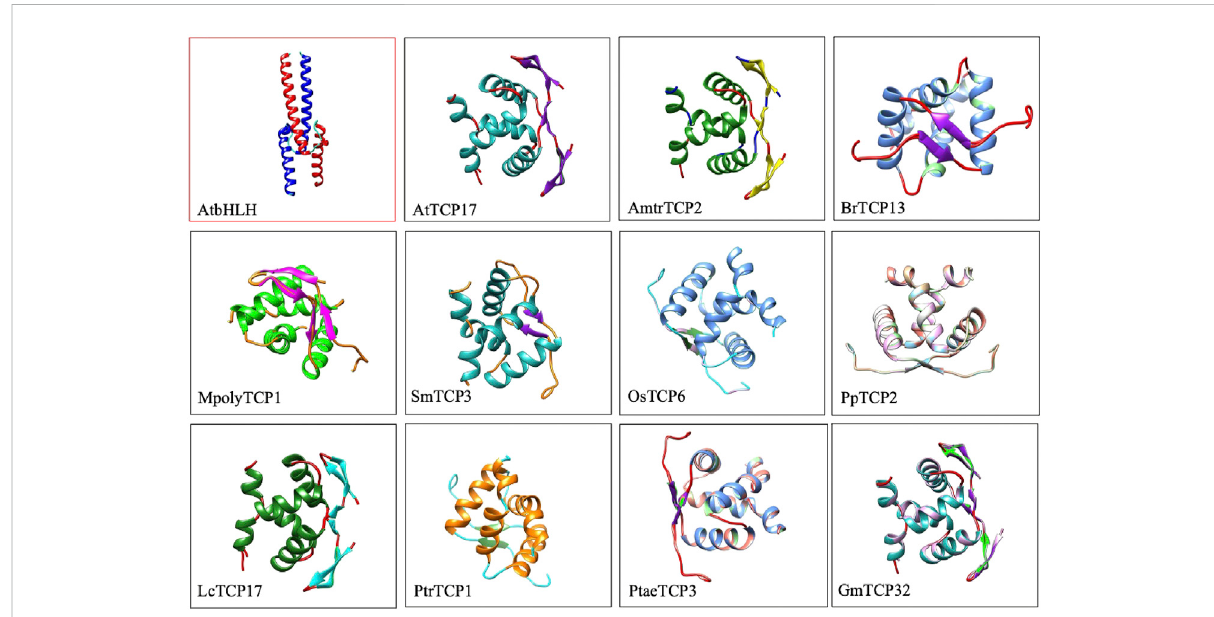
FIGURE 1 3D protein structure comparison of Arabidopsis bHLH3 against other 11 TCP proteins. Speci fi c names of the TCP protein are highlightedbelow the image. 3D protein structures were searched against the online PDB database (https://www.rcsb.org/) and viewed using the chimera